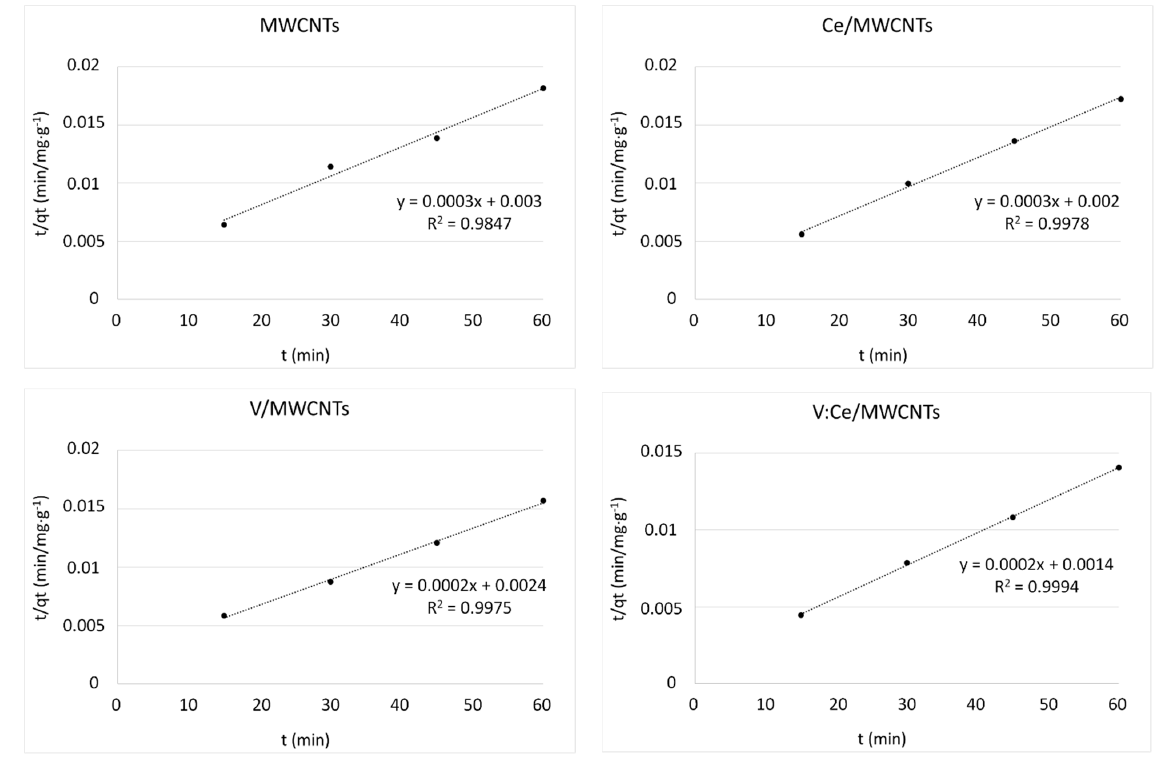
Figure 11. Pseudo-second order plot for kerosene adsorption onto metal oxide-modified MWCNTs. According to this theory, the adsorbate uptake, q t , varies almost proportionally to the square root of the contact time, t 1 2 , rather than t [66]. Figure 12 is the outcome of this third kinetic model. The constant K d was obtained from the gradient of the plot of q t versus t 1/2 (Table 4). The achieved plot does not pass through the origin with linear response values and R 2 varied between 0.90 and 0.99 for all samples.